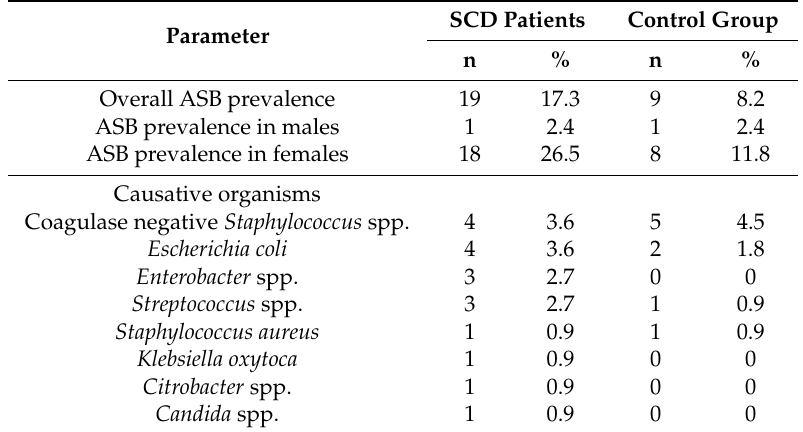
Table 2. ASB prevalence and causative organisms of SCD patients and healthy controls. SCD Patients Control Group Parameter n % n % Overall ASB prevalence